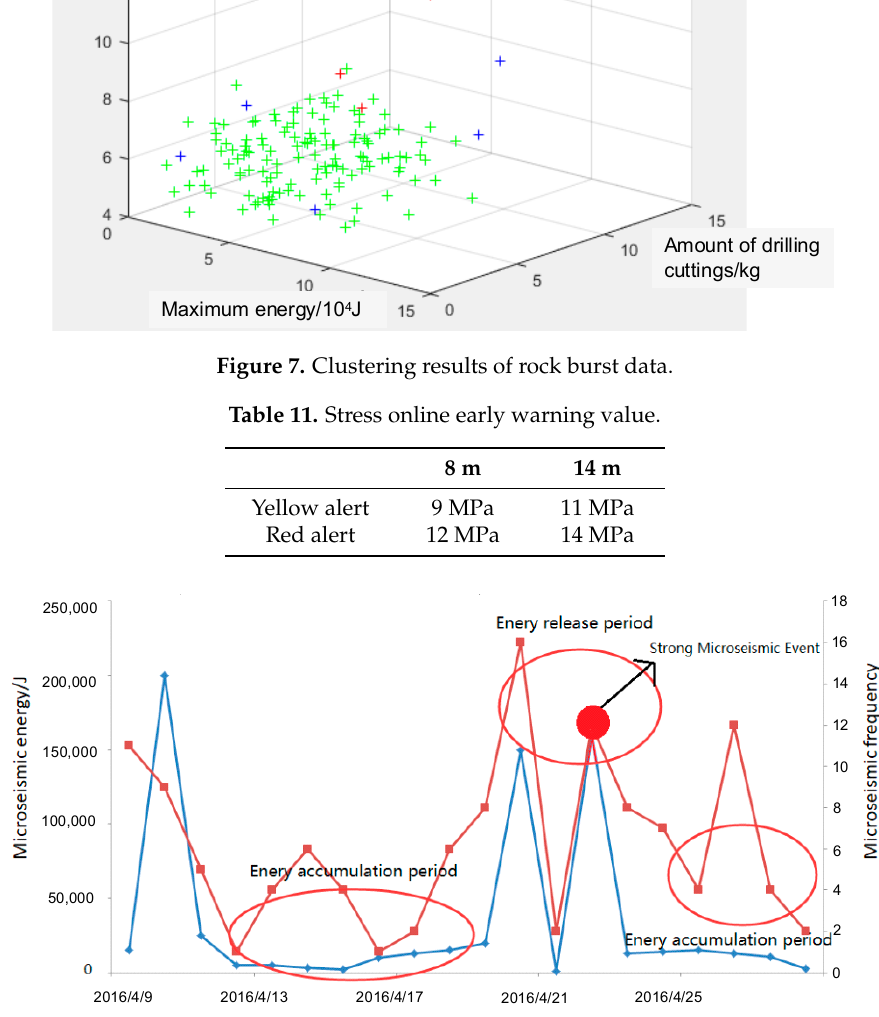
Figure 8. Distribution of field microseismic events.